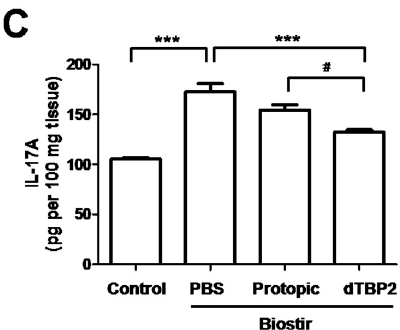
Figure 3. dTBP2 reduces the levels of IgE, histamine, and IL-17A in the house dust mite-induced AD mouse model. ( A , B ) Blood samples were collected immediately by making a puncture in the heart after sacrifice. Cells were removed by centrifugation and the plasma was carefully transferred into a new tube. The serum levels of IgE and histamine were measured using specific ELISA kits according to the manufacturer’s instructions ( n = 5); ( C ) After sacrifice, dorsal skin biopsies were taken from each group, homogenized, and analyzed for the levels of IL-17A using ELISA kits ( n = 5). Data are presented as the mean ± SEM of one experiment performed in triplicate. *** p < 0.0001, treatment group compared with Biostir-PBS group; # p < 0.05, dTBP2-treated group compared with Protopic-treated group.